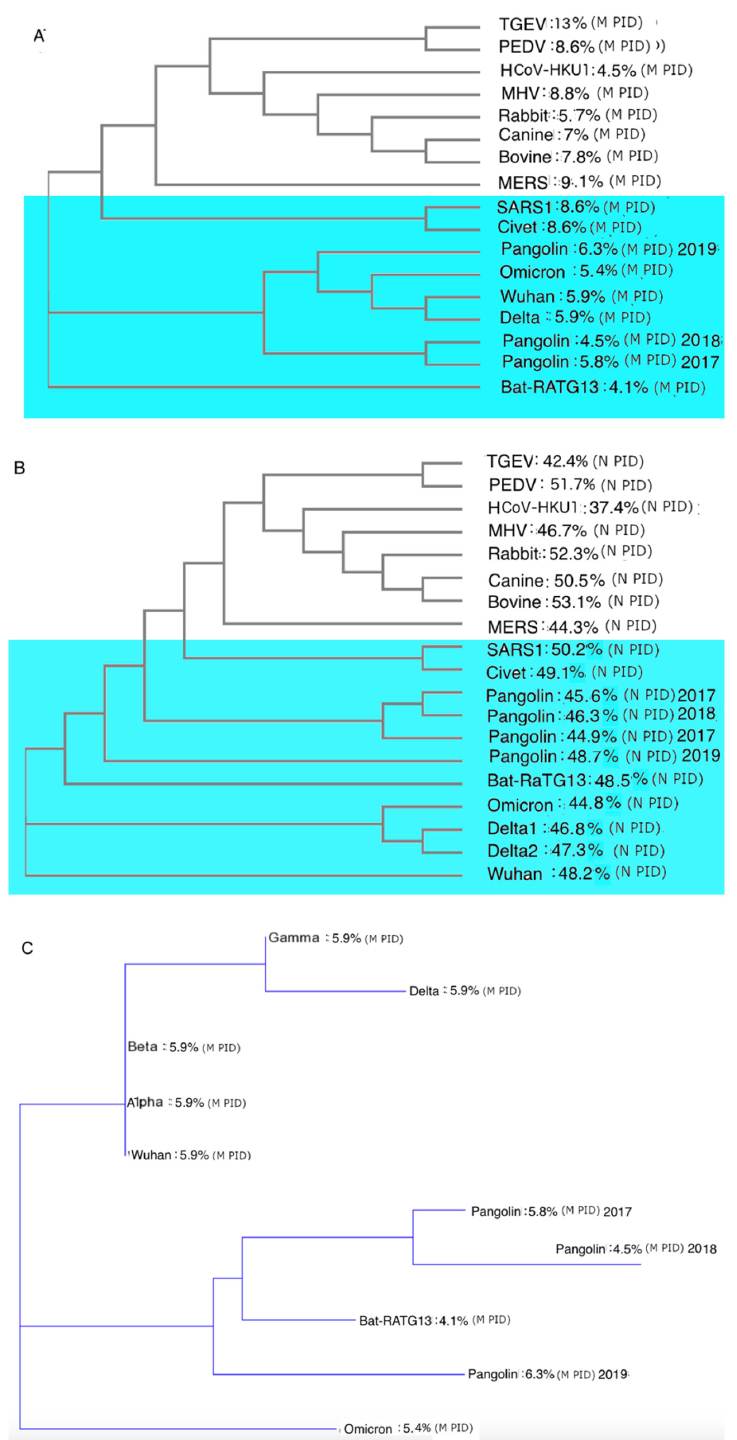
Figure 4. Phylogenetic trees using M (membrane) and N (nucleocapsid) proteins. ( A ) Phylogenetic tree using M protein. ( B ) Phylogenetic tree using N protein. ( C ) Phylogenetic tree using M protein for COVID-19-related variants and strains showing Omicron to be an entirely different branch from the other SARS-CoV-2 variants, and closer to pangolin CoVs. (Additional NCBI accession codes for M proteins: QXY06216 (Alpha), QWA53378 (Beta), and QWW7597 (Gamma). The phylogenetic tree in ( C ) includes distance correction, unlike those in ( A , B ).